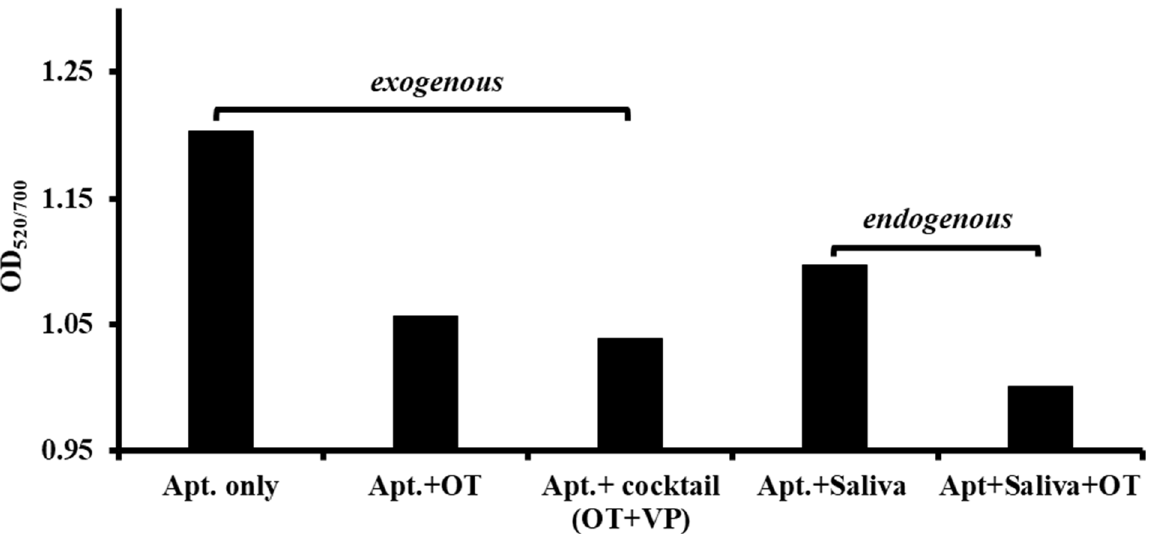
Figure 3. Exogenous and endogenously expressed oxytocin detection and their specificity analysis. Raptamer conc. was 400 nM (ng/mL), OT = 100 ng/mL, VP = 140 ng/mL.